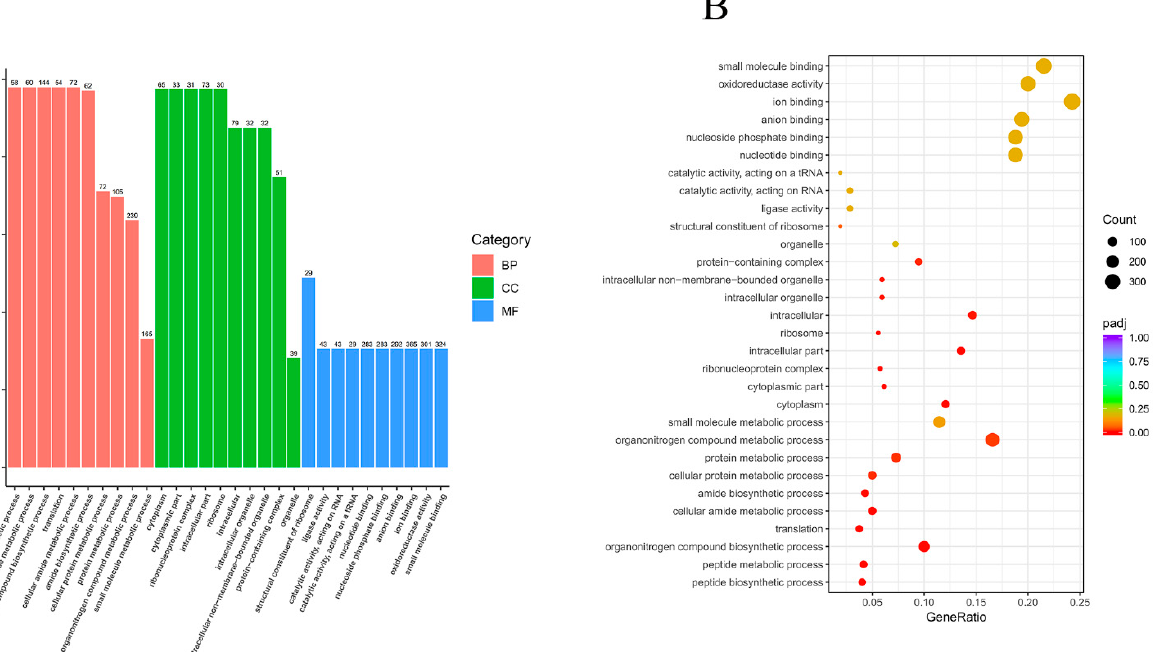
Table 2. Partial results of KEGG enrichment analysis (top 10).